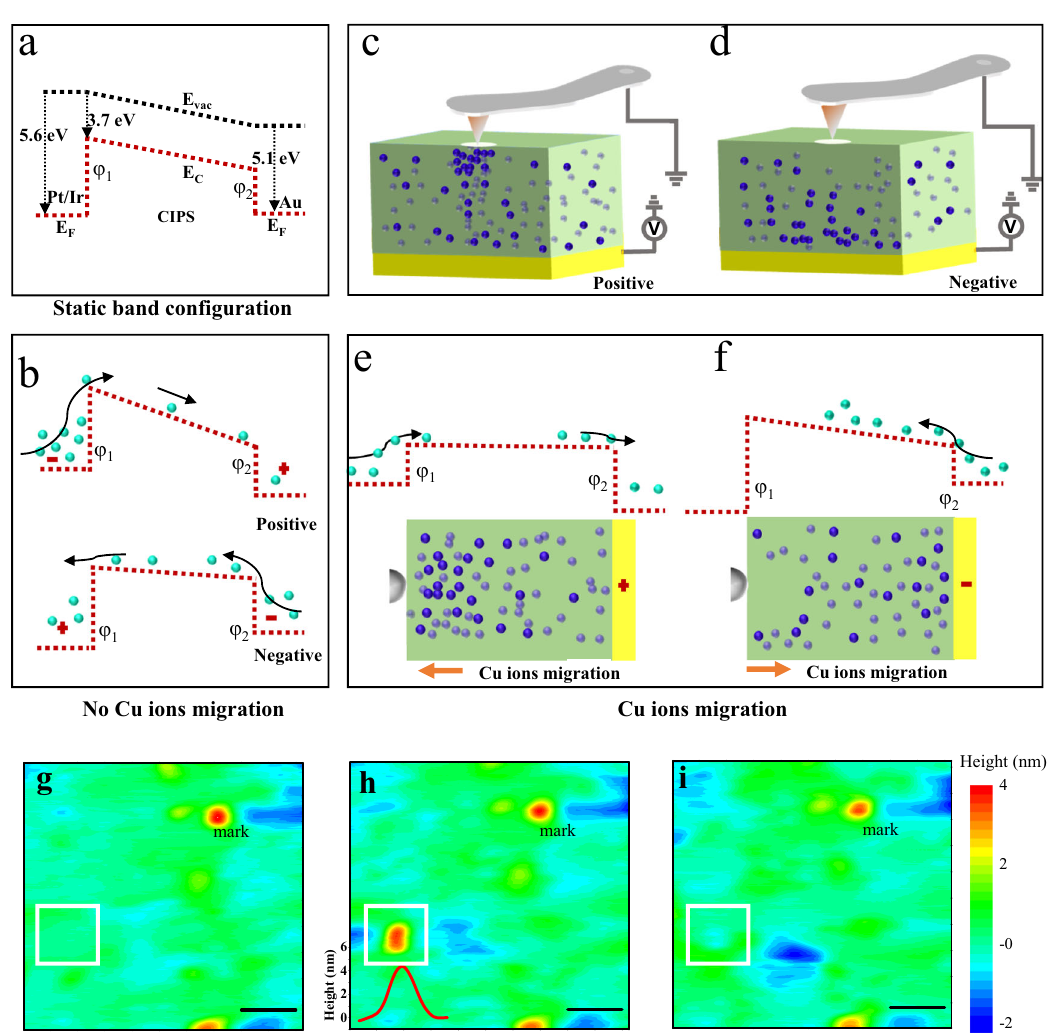
Fig. 3 Physical mechanism of highly mobile Cu + ions-meditated current recti fi cation. a Schematic static band con fi guration for tip/CIPS/Au bottom electrode measurement setup according to the work function of Pt/Ir tip (5.6 eV) 42 , Au (5.1 eV) 43 , and electron af fi nity of CIPS (3.7 eV) 44 . The difference in the work function/electron af fi nity creates asymmetric interfaces, with the Schottky barrier φ 1 and φ 2 at the side of Pt/Ir tip and the bottom Au electrode, respectively; b In the absence of Cu + ions migration, the schematic electrons (cyan balls) transport process in different bias direction, where the bias voltage is applied to the bottom Au substrate; c , d Cu + ions (blue ball) undergo directional migration driven by the applied voltage. e , f In the presence of Cu + ions migration and redistribution, the schematic Cu + ions (blue balls) migration and electrons (cyan balls) transfer for current fl ow. g – i The topography image in virgin state, after two consecutive positive voltage sweeping semi-cycle (0 V → + 4 V → 0 V), and after two consecutive negative voltage sweeping semi-cycle (0 V → − 4 V → 0 V), respectively. The I – V measurements are conducted in the white square area in g – i and the ever-present bump in the mark location rules out the possibility of tip scraping for the bump elimination during scanning. The scale bar length is 200 nm in g – i